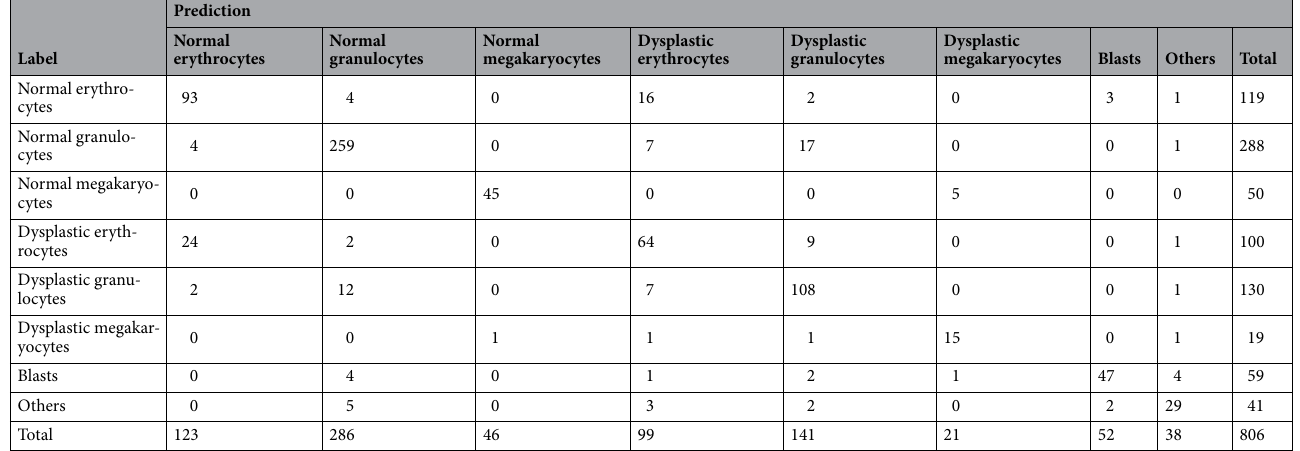
Table 4. Confusion matrix for disease diagnosis from